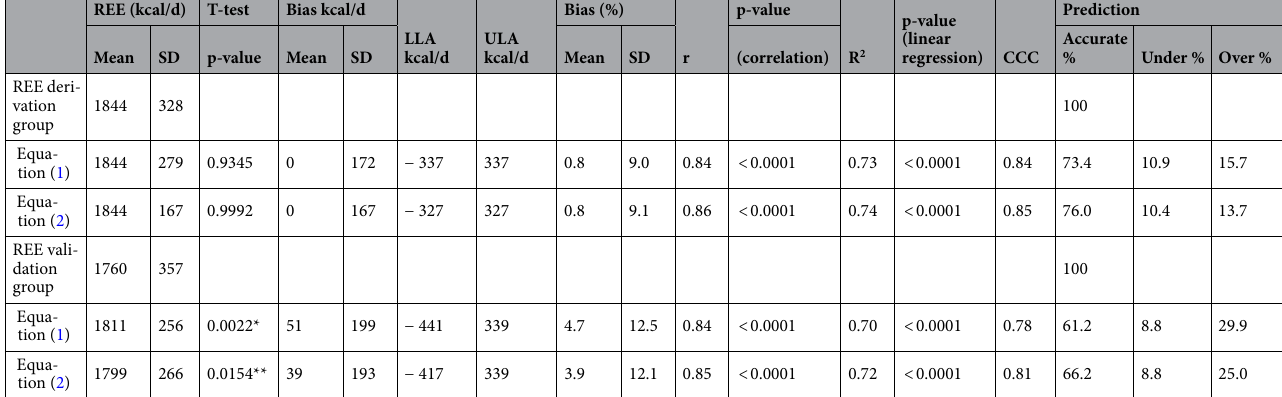
Table 3. Validity of the resting energy expenditure. REE measured resting metabolic rate by IC, SD standard deviation, Bias difference between the predicted value and the measured REE, LLA lower limit of agreement, ULA upper limit of agreement, bias% bias in %, CCC concordance correlation coefficient, Accurate % percentage of subjects in which the error of the predictive equation was within 10% of the measured value, Under % percentage of subjects underestimated by the predictive equation with an error > 10% of the measured value, Over % percentage of subjects overestimated by the predictive equation with an error > 10% of the